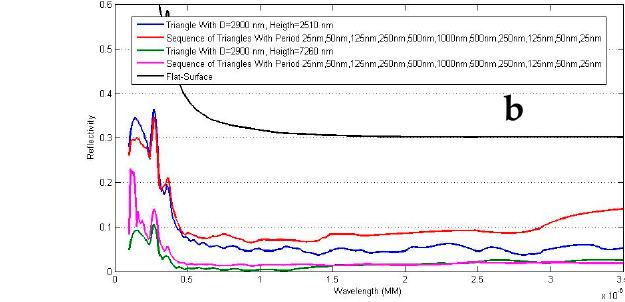
Figure 7. ( a ) Schemes of height distribution of triangular microstructure, ( b ) Spectral reflection based on the base size and height of triangular microstructures.